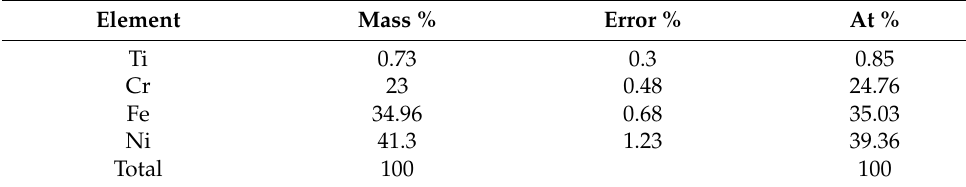
Figure 4. SEM image and surface scan energy maps of Incoloy 825 alloy layer (red color-Ti, blue color-Ni, and green color-Cr).